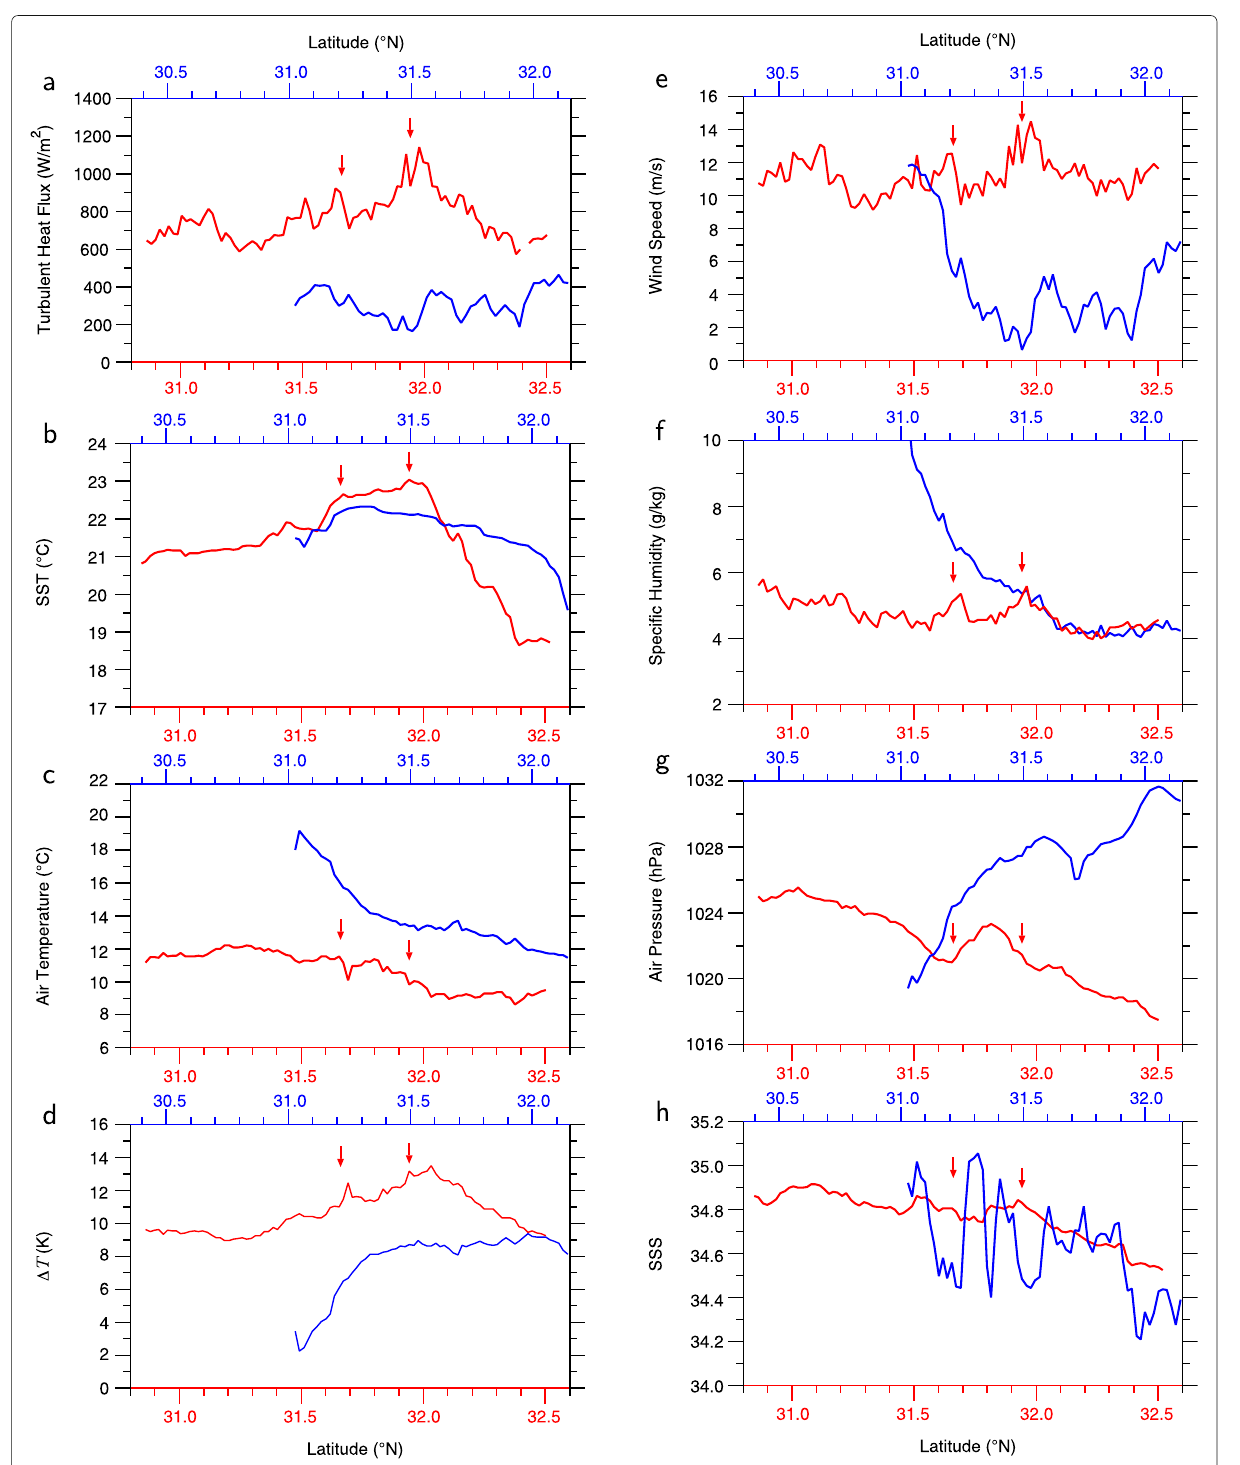
Fig. 7 a Turbulent (latent plus sensible) heat flux, b sea surface temperature (SST), c air temperature, d air-sea temperature difference, e wind speed, f specific humidity, g air pressure, and h sea surface salinity (SSS) on the A (red lines) and B (blue lines) tracks. Values were averaged within approximately 2km intervals. Positions where the Saildrone observed the maximal surface current speed on the tracks are matched to make a comparison. Red arrows indicate locations of SST peaks corresponding to wind speed